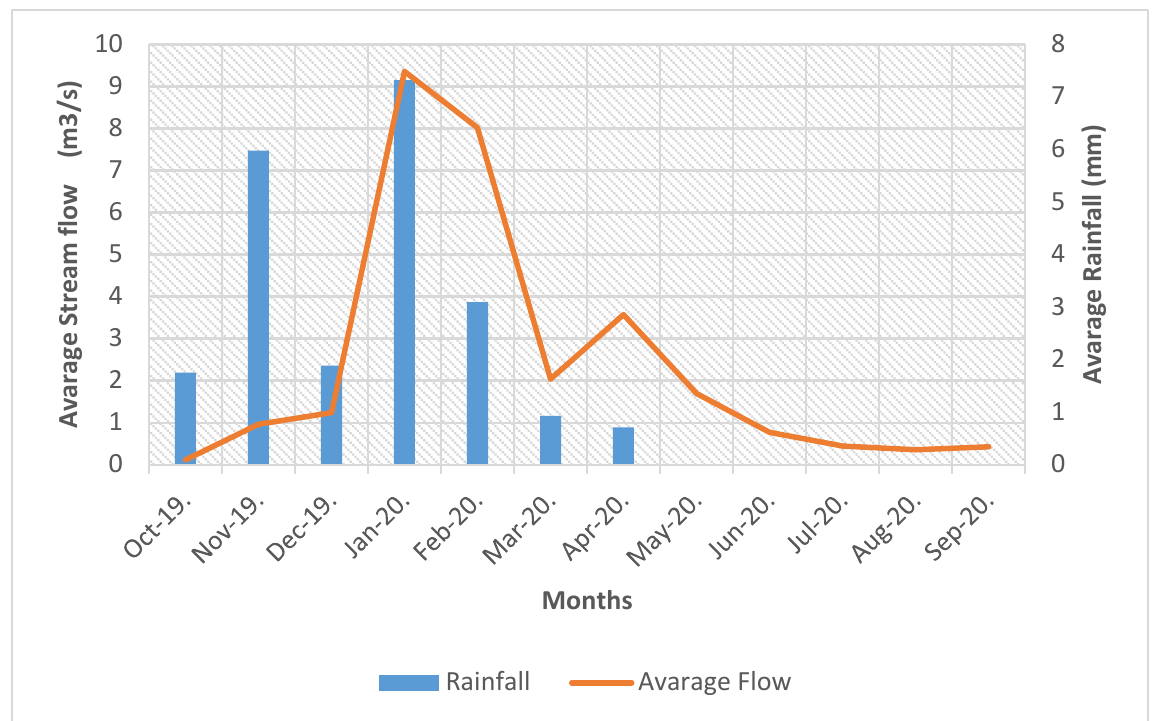
Figure 12. Average Monthly Rainfall and Streamflow at Sand River Catchment.